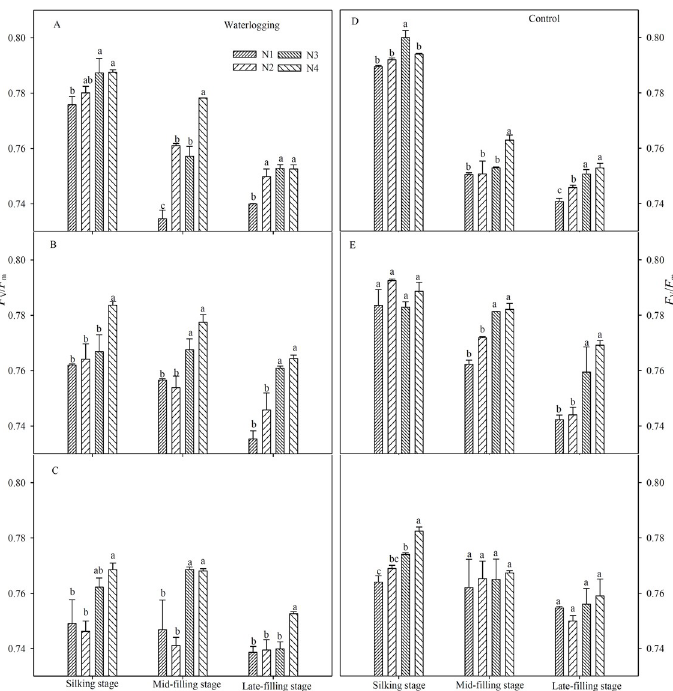
Fig 3. Maximal efficiency of PSII ( F v / F m ) in different leaf layers under different N treatments (2014). The error bars represent the standard errors of the mean. Different letters above the bars indicate significant differences ( p < 0.05) among the different N treatments. A,D: above-ear leaves; B,E: ear leaves; C,F: below-ear leaves. N1: 100% N applied as basal fertilizer, N2: 70% N applied as basal fertilizer and 30% N applied at the jointing stage, N3: 50% N applied as basal fertilizer and 50% N applied at the jointing stage, N4: 30% N applied as basal fertilizer, 50% N applied at the jointing stage and 20% N applied at the big flare stage.